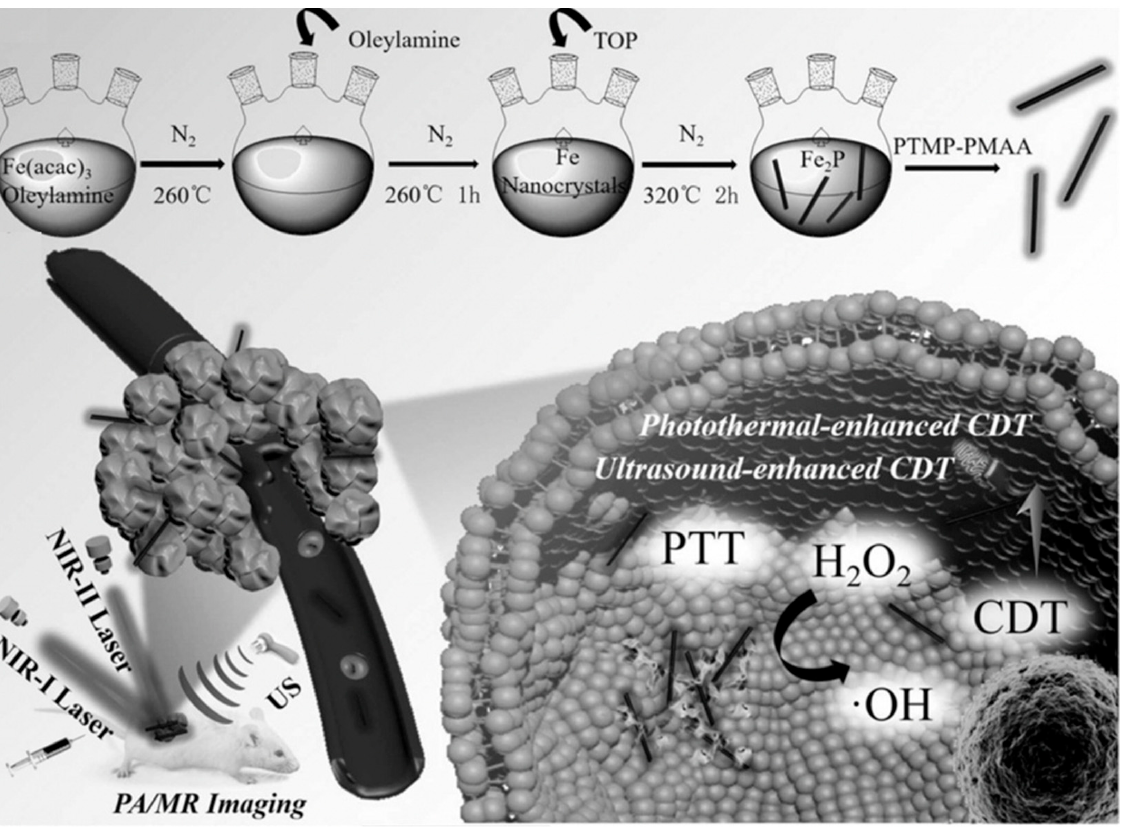
Figure 5. Schematic illustration of the synthesis of FP NRs and their applications for US/PT-enhanced CDT and PTT in the NIR I/II window. PTMP stands for pentaerythritol tetrakis 3-mercaptopropionate and TOP stands for trioctylphosphine. Reprinted with permission from Ref. [69]. Copyright 2019, Wiley-VCH Verlag GmbH & Co. KGaA, Weinheim.